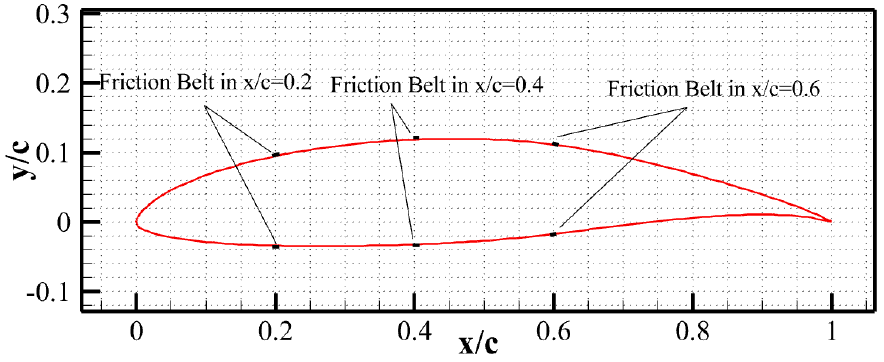
Figure 7. NLF-1015 airfoil and roughness bands’ distribution.